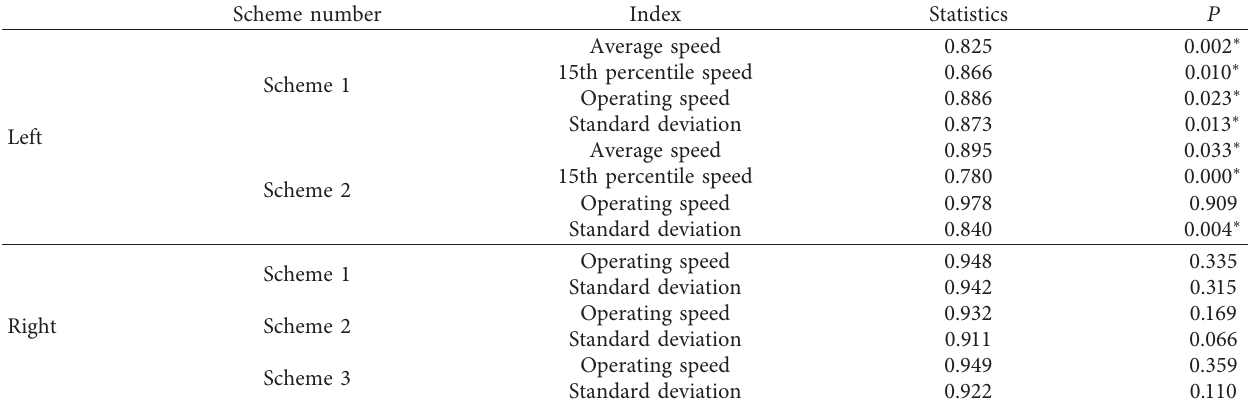
Figure 9: Angular velocity of driver’s steering wheel for different right lateral clearances. (a) Angular velocity change of different schemes. (b) Comparison of angular velocity box plots of different schemes. Table 3: SW normal test result.